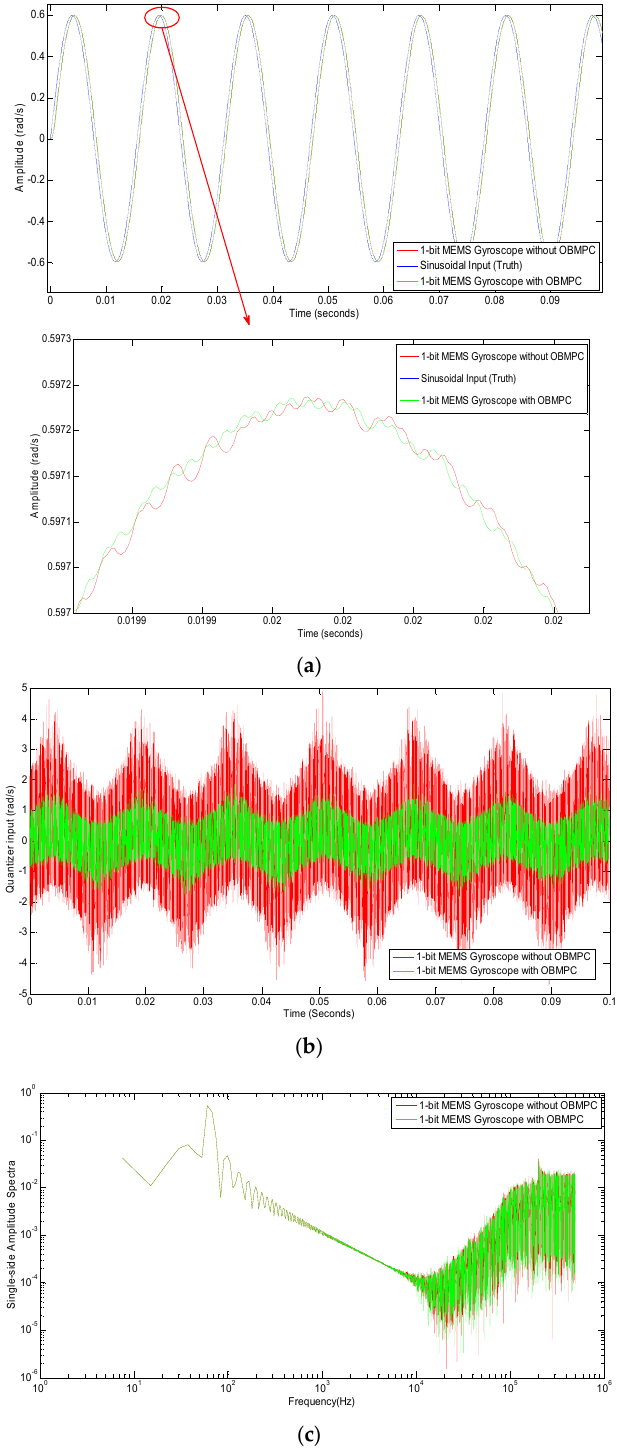
Figure 11. Results for the Δ∑ modulator-based MEMS gyroscopes with Amplitude = 0.6 rad/s: ( a ) MEMS gyroscopes with sinusoidal input; ( b ) Comparison of the quantizer input; ( c ) Spectra comparison. The amplitude of the input signal shall now be increased to 1.1 rad/s, so that the quantizer will be overloaded. Constraints and clippers are set to both systems respectively according to Equation (2). The tracking trajectory and the spectra of both systems are plotted in Figure 12. In this scenario, the OBMPC-based MEMS gyroscope shows a notable improvement in comparison to its